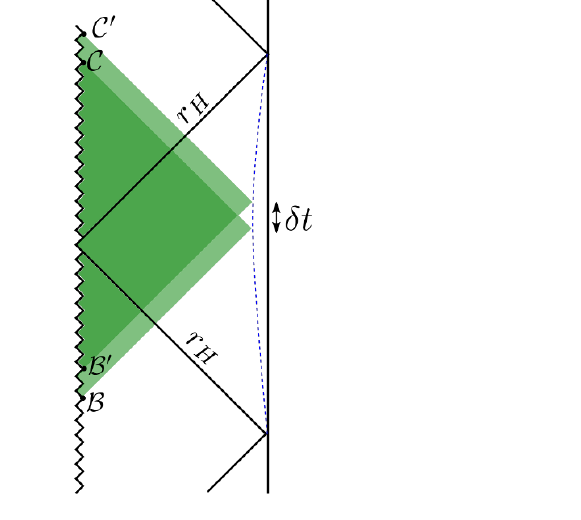
Figure 1 . WdW patch for a charged extremal black hole. The bulk volume and boundary contri- butions are conserved by the isometries of the spacetime, whereas the joint piece vanishes due to the sphere shrinking at the